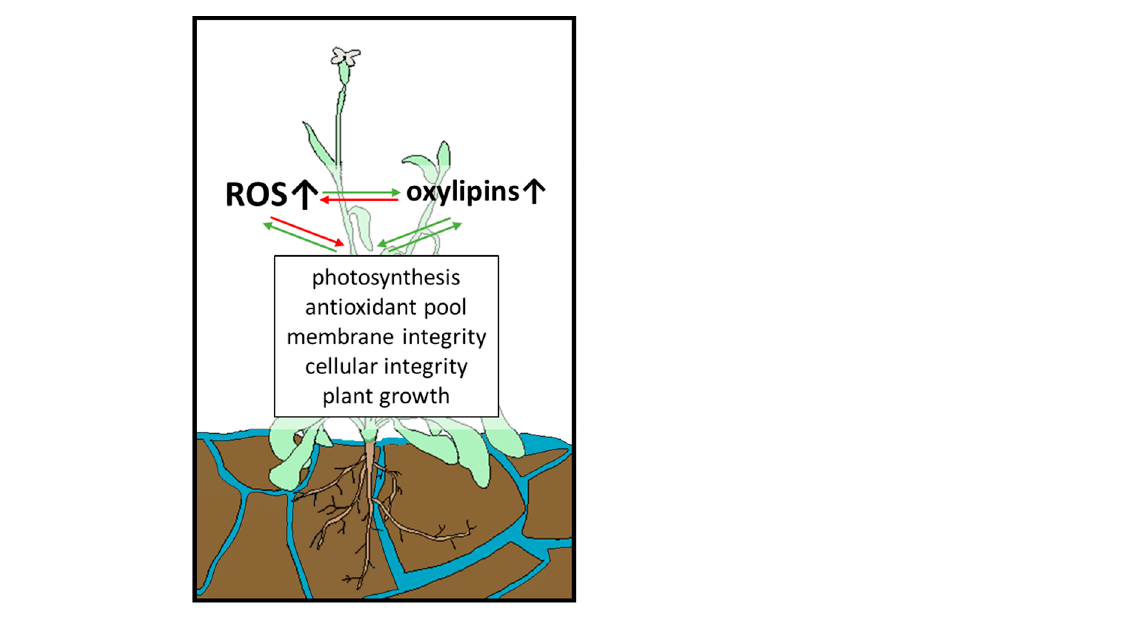
Figure 7. Waterlogging stress increases ROS content in plant cells, which impairs essential functions such as photosynthesis, and is counteracted by oxylipins. ROS accumulation can lead to extensive damage in plant cells, damaging, for example, membrane integrity, which leads to enhanced oxylipin synthesis. Oxylipins stimulate thiol synthesis and the subsequent increase of the antioxidant pool or regulate protein activity of detoxifying enzymes to ameliorate oxidative stress. Legend: green arrows: positive impact; red arrows: negative impact.